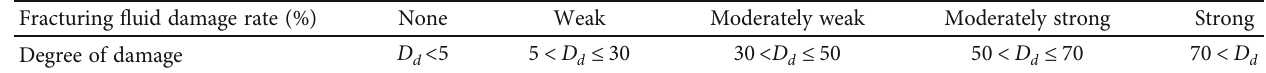
Table 5: Parameters of damage evaluation of fracturing fl uid.